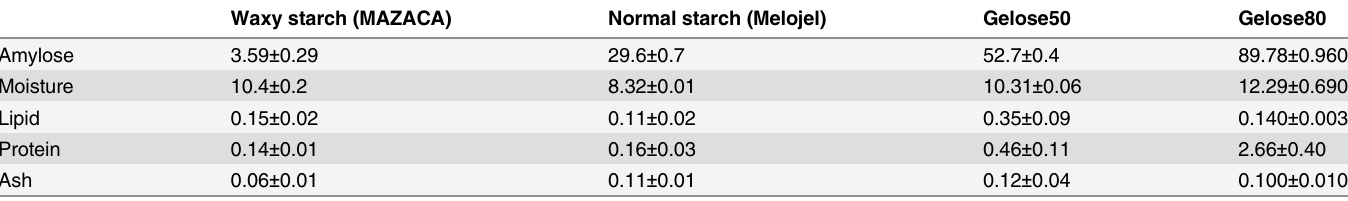
Table 1. Chemical composition (w/w, %) of the maize starches